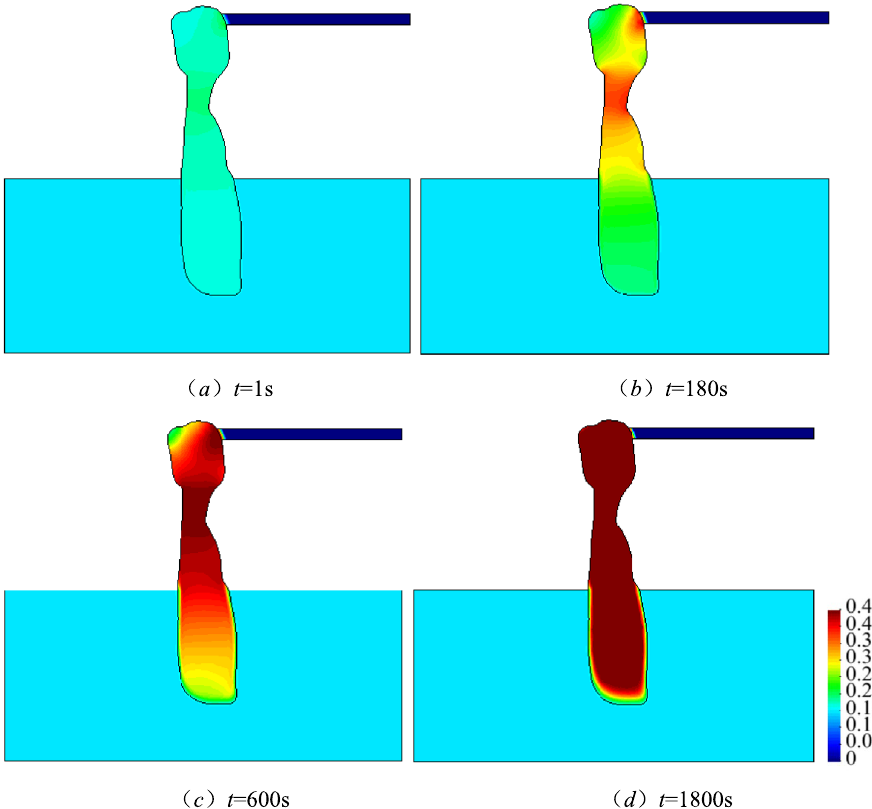
Figure 11. Space–time evolution process of porosity.